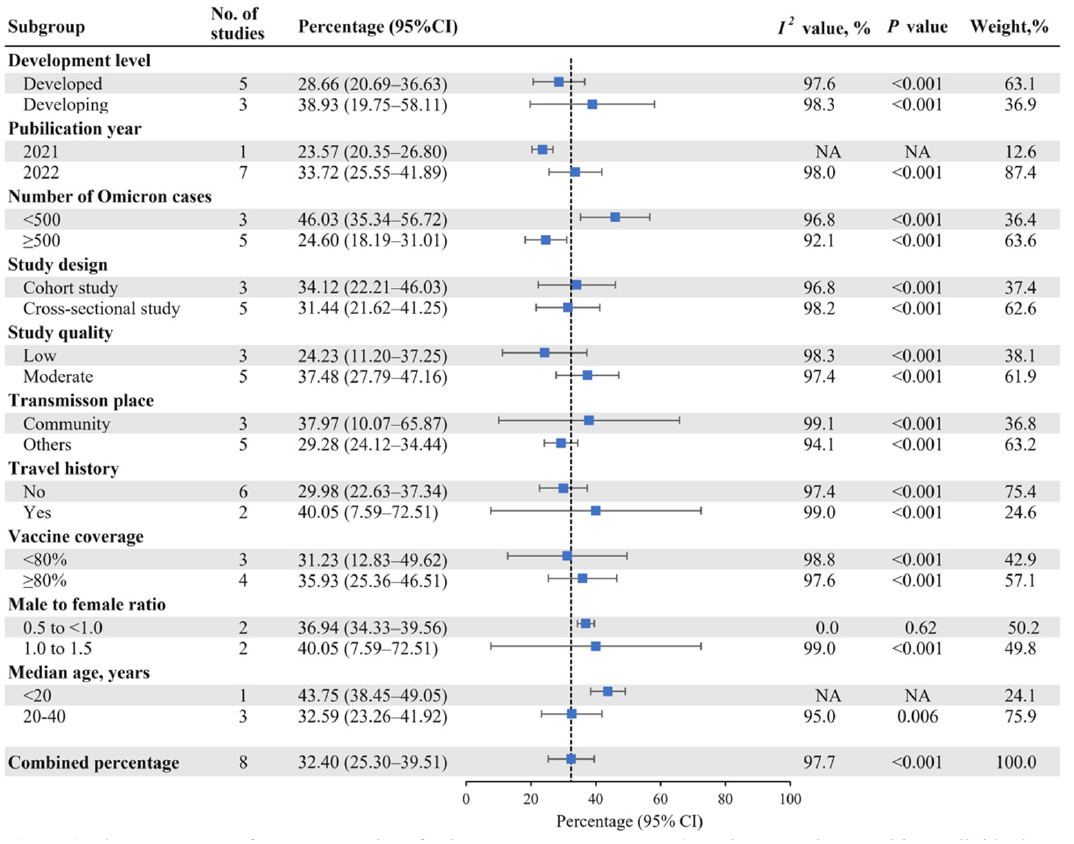
Figure 3. The Percentage of Asymptomatic Infections Among SARS-CoV-2 Omicron Variant-Positive Individuals by Subgroup.